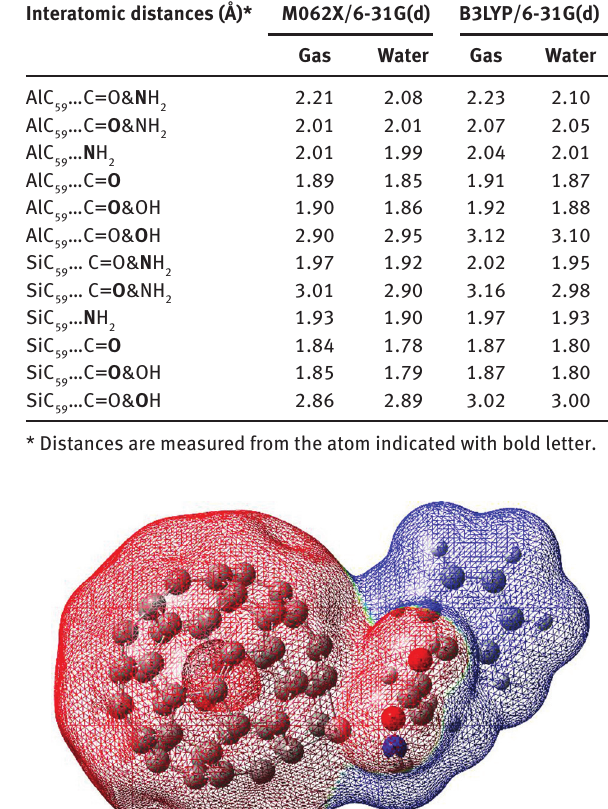
Figure 3: MEP on AlC ranges, in a.u.: blue: more positive than 0.003 and red: more negative than -0.003.